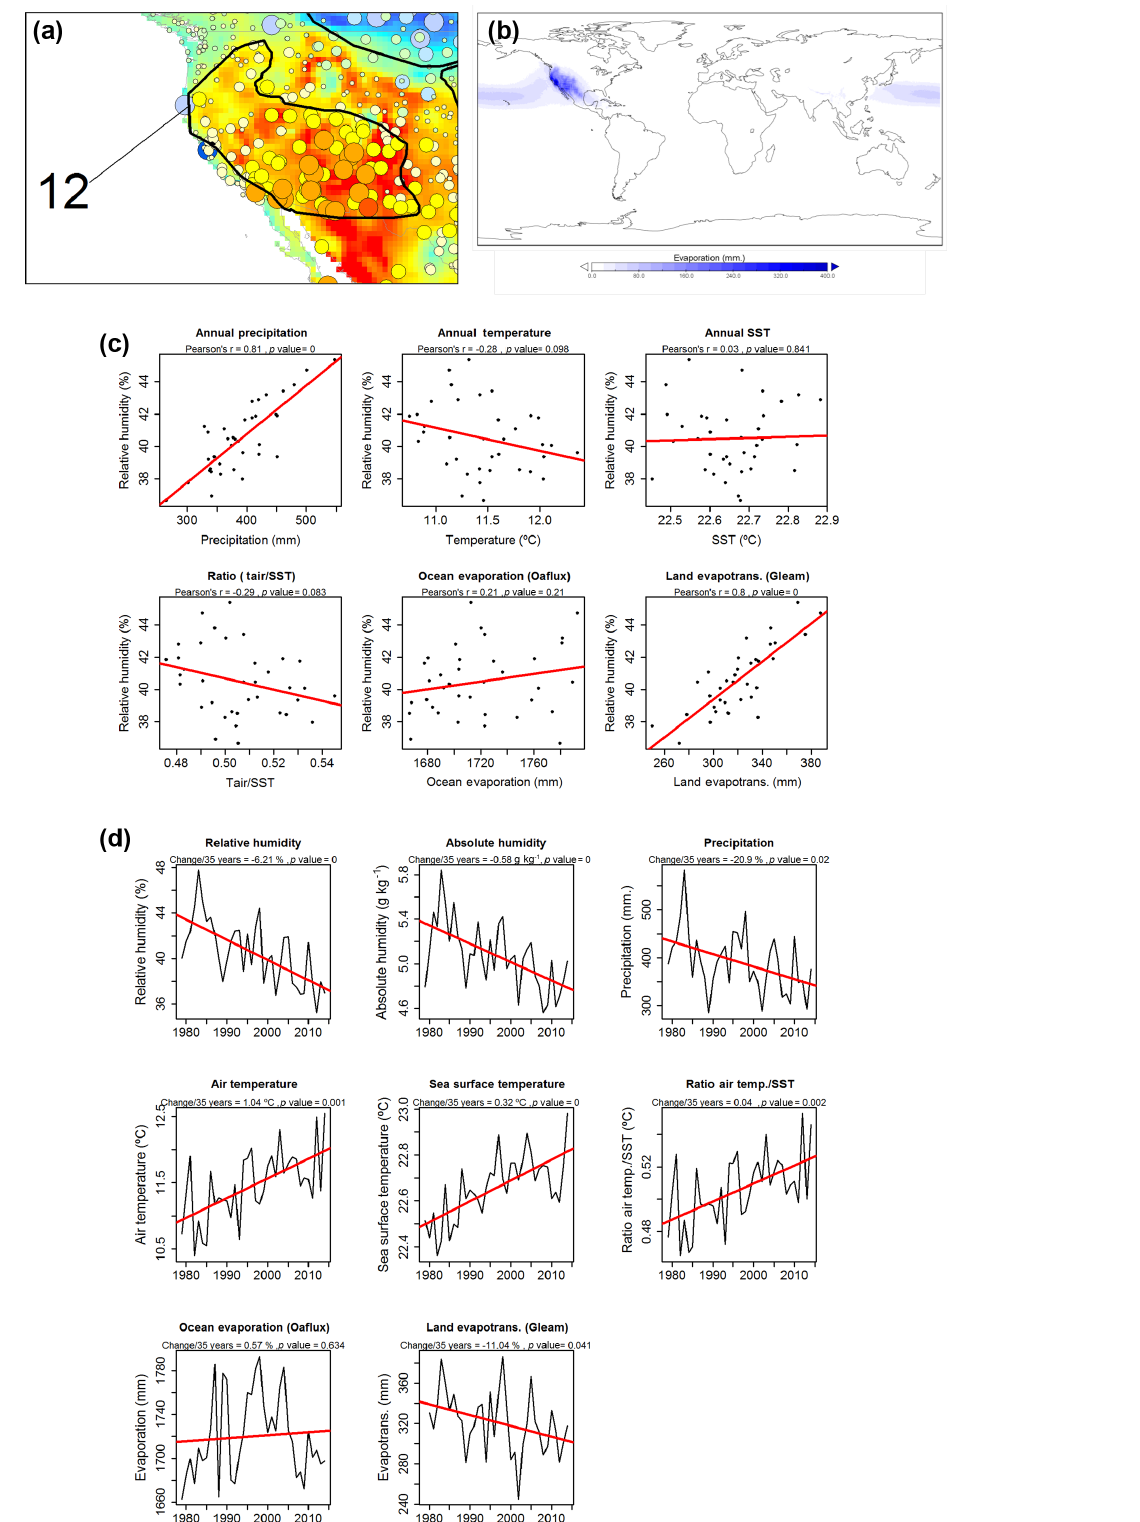
Figure 7. The same as Fig. 5 but for western North America (region